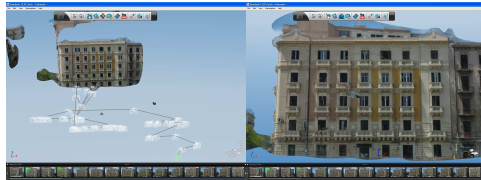
Figure 3: 123D Catch : civil building (A) in Palermo